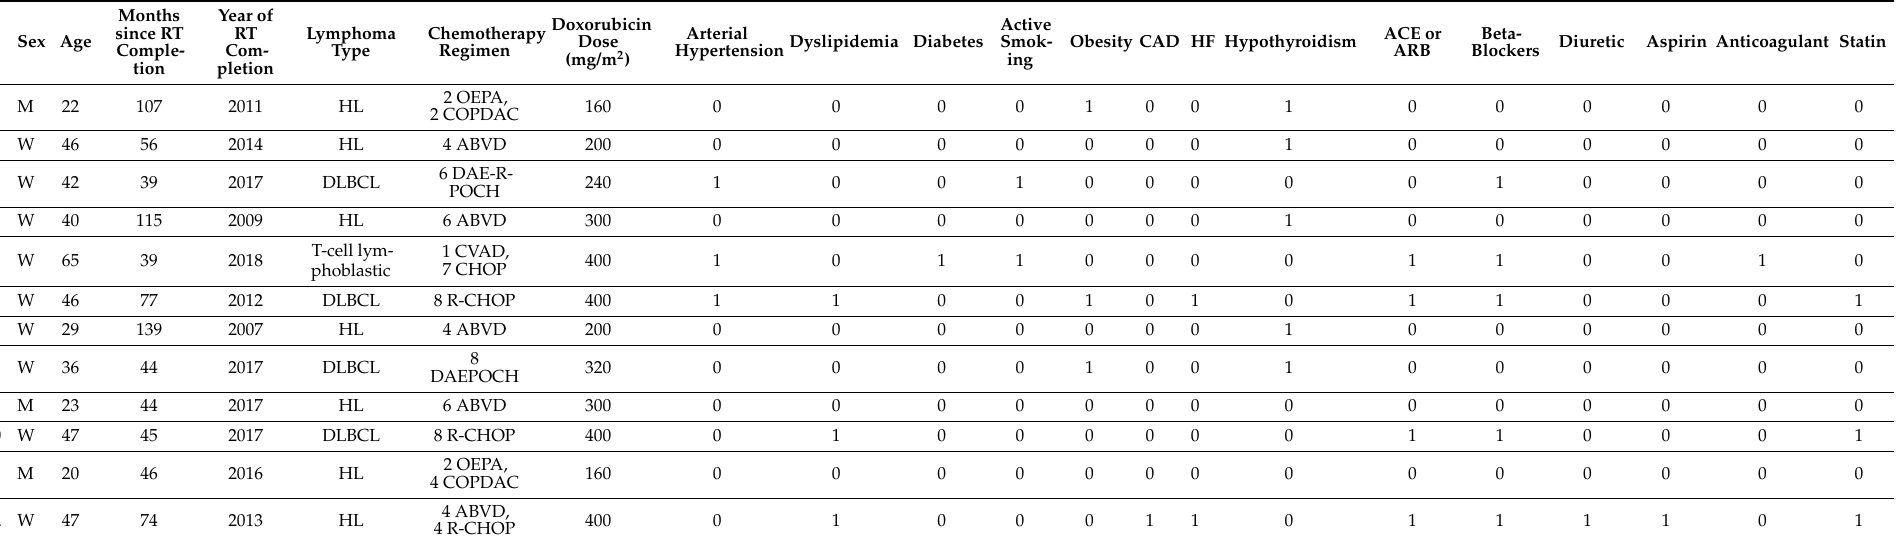
Table 1. Data on lymphoma and patients’ characteristics at the time of echocardiographic